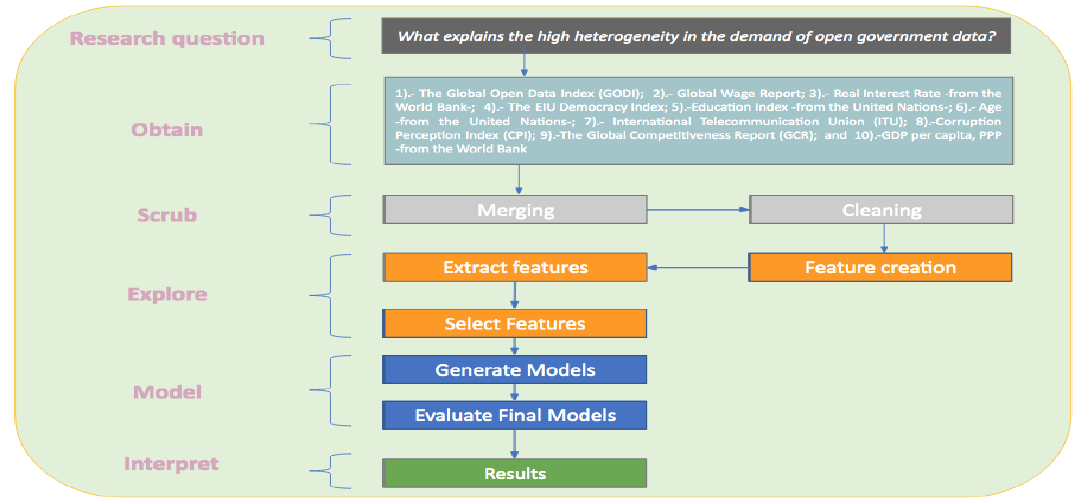
Figure 4. Illustration of the data science pipeline developed for our research.